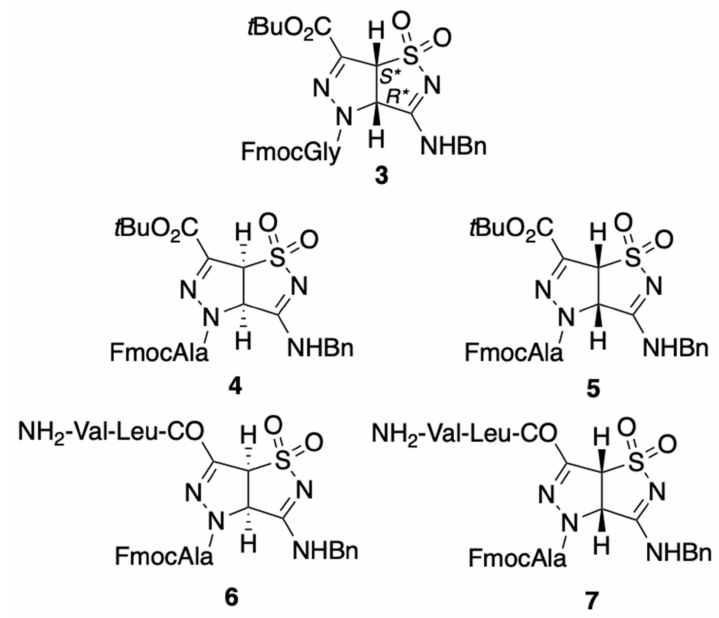
Figure 7. Chemical formulae of peptidomimetics 3 – 7 . Electrospinning of compound 3 in HFIP (30 wt.%) gave continuous fibers (600 nm diameter), which were fairly homogenous and without any beads. SEM confirmed the formation of fully filled fibers (Figure 8).